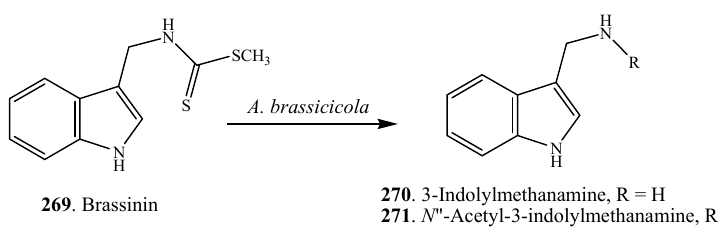
Figure 15. Detoxification pathway of the phytoalexin brassinin ( 269 ) by the pathogen A. brassicicola [51].